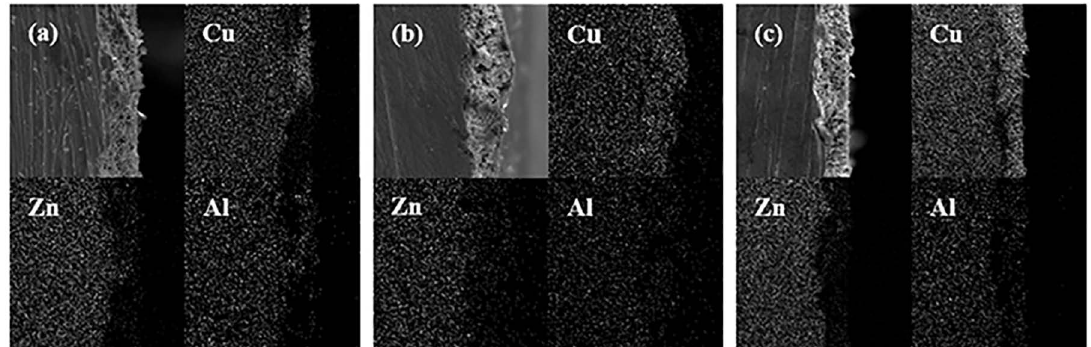
Figure 5. The elements distribution character of corroded surface of aluminum brass alloy with and without EPT (a) Original Sample (b) 500 V (c)700 V